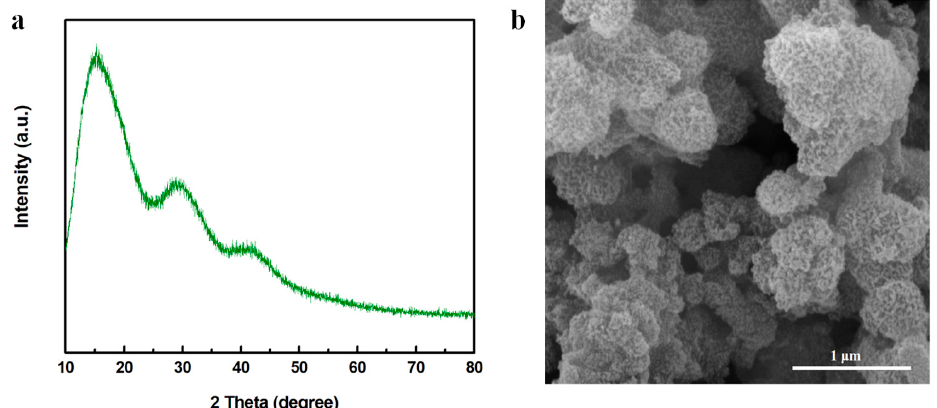
Figure 3. ( a ) XRD pattern and ( b ) SEM image of MnO 2-x /PANI. FTIR was used to further investigate the structure. In Figure 4a, the peaks at 1504.4 and 1575.8 cm − 1 were attributed to the stretching vibration of the benzenoid and quinoid ring, respectively. The peak at 1298.1 cm − 1 corresponded to the Ph-N group and the peak at 1172.7 cm − 1 suggested the electron delocalization of conductive PANI [43–47]. Moreo- ver, the peak at 503.4 cm − 1 was assigned to the stretching of the Mn-O bond, indicating the